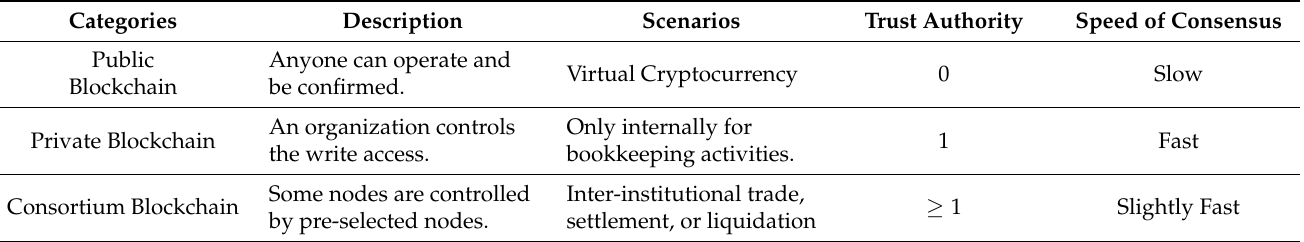
Table 2. The categories of